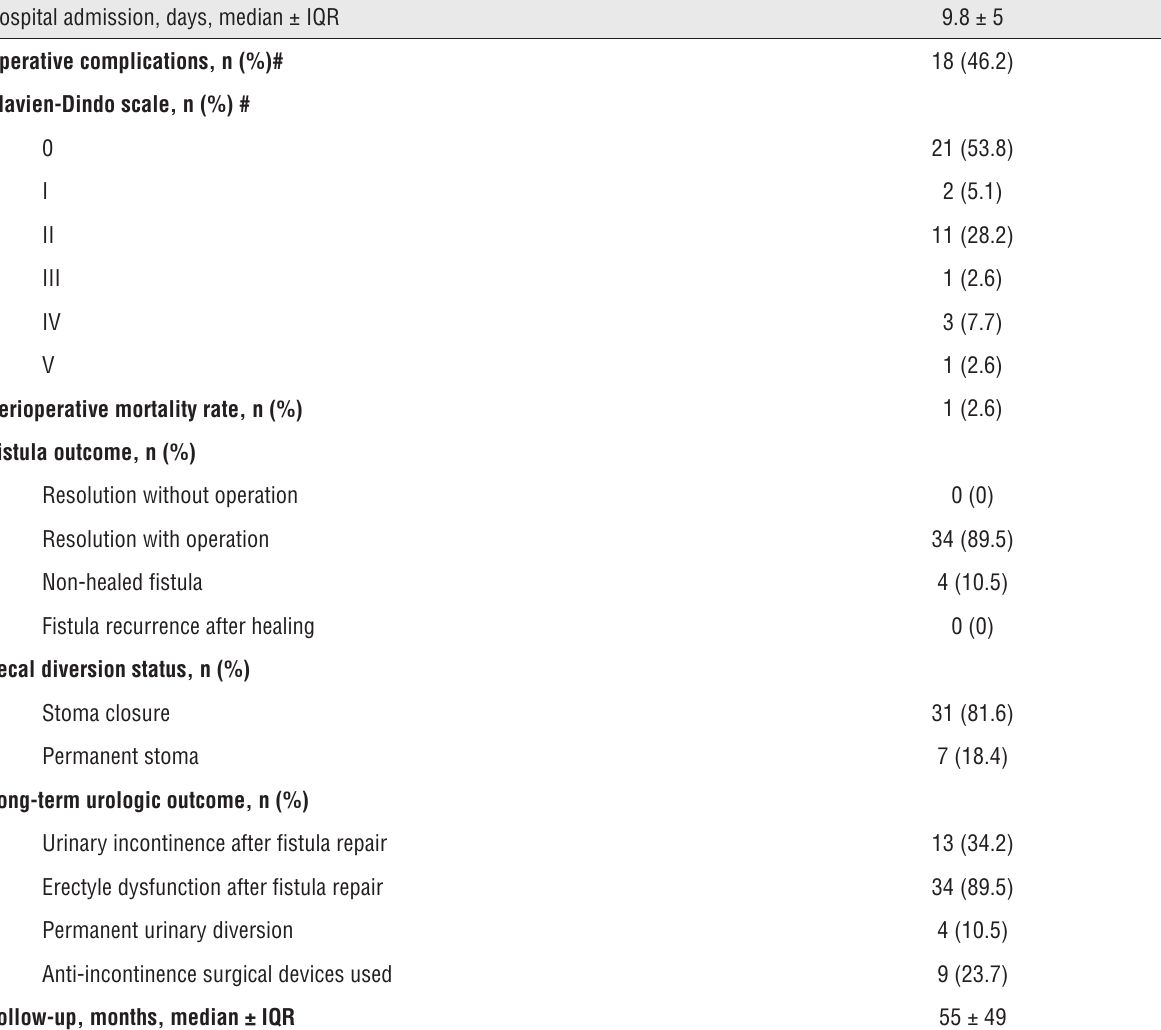
Table 2 - Operative data, complications and outcomes (n=39)